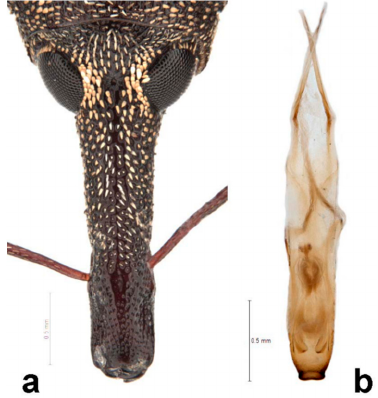
Figure 16. Notopissodes pictus : ( a ) rostrum of male, dorsal aspect; ( b) aedeagus, dorsal aspect. Notopissodes variegatus Oberprieler, new species (Figure 17) Notopissodes sp., Pullen et al., 2014: 470 [2].